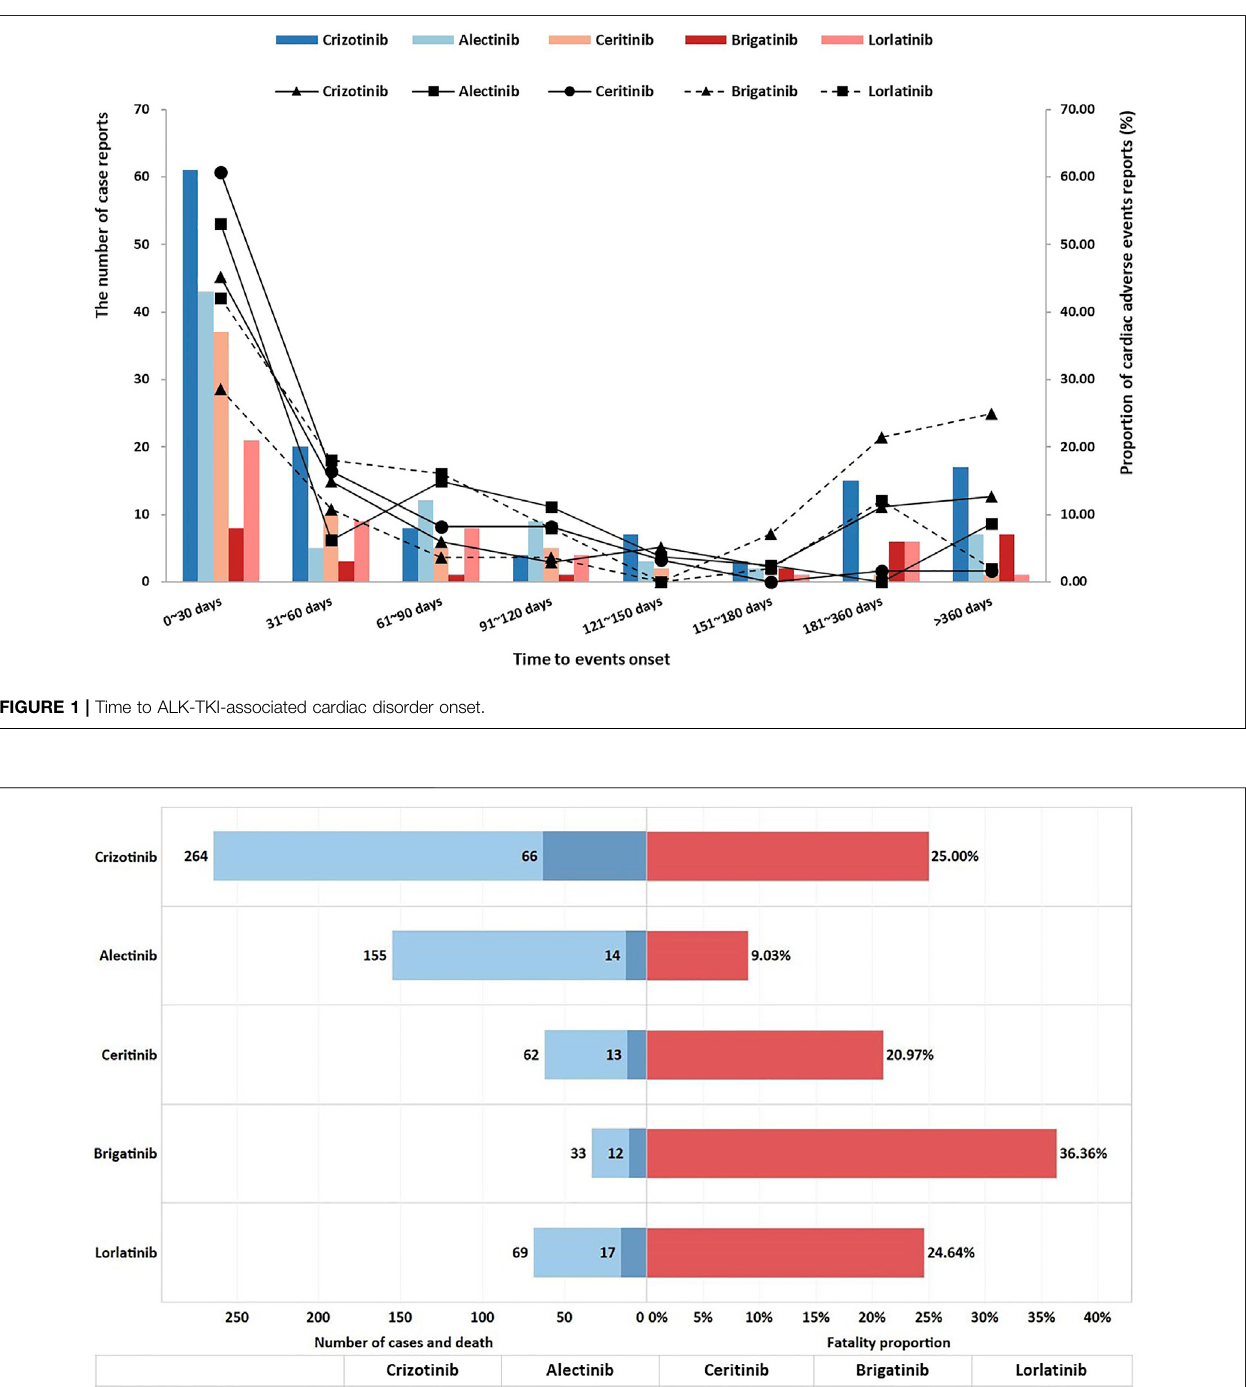
Frontiers in Pharmacology |